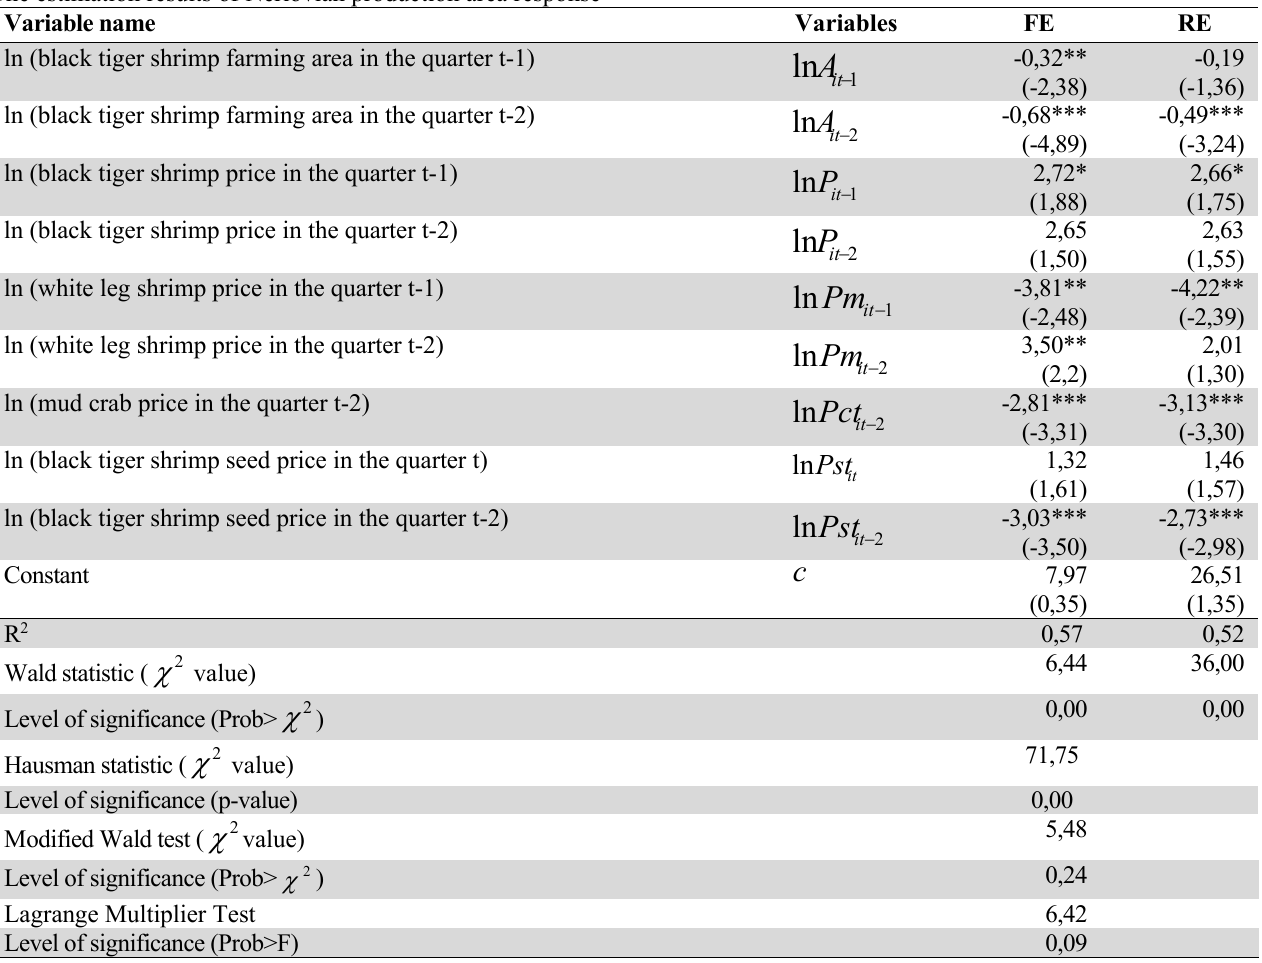
The estimation results of Nerlovian production area response